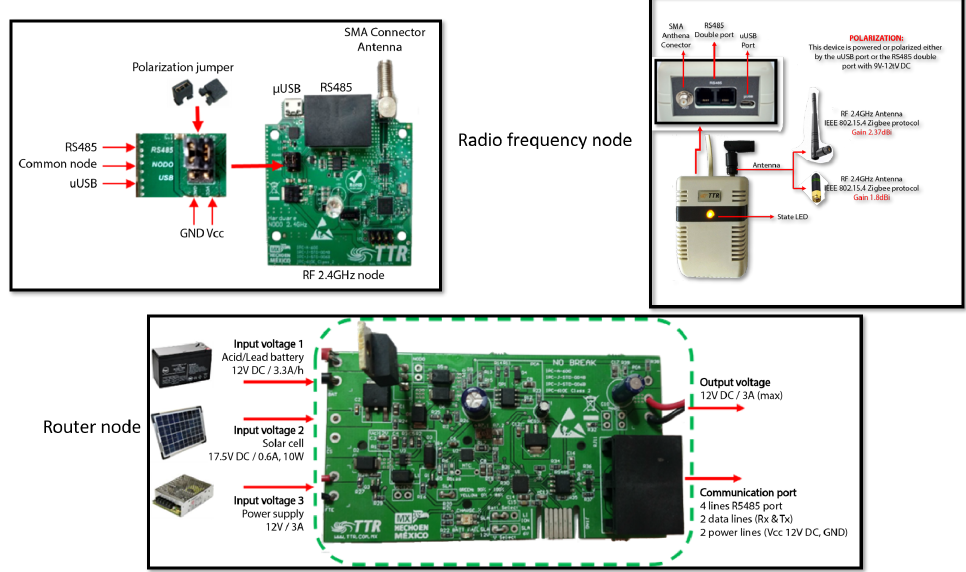
Figure 3. Router node and radio frequency nodes’ circuits, schematics, and